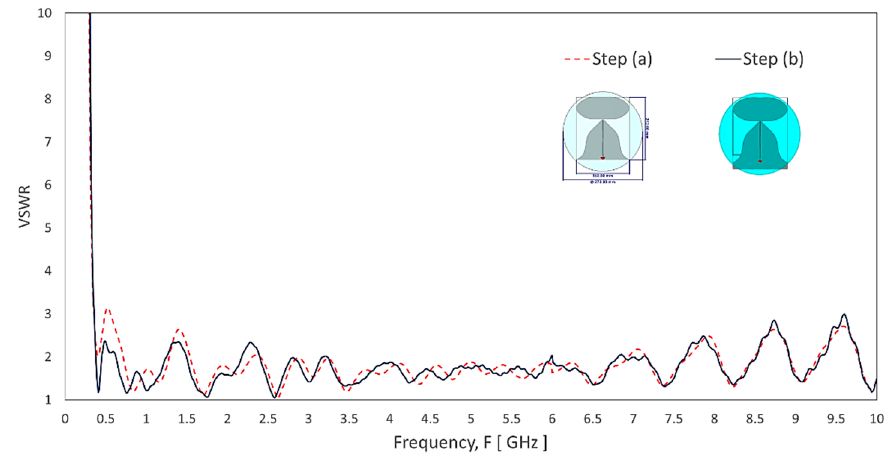
Figure 6. The simulated VSWR of the evolution steps from Figure 4: Step (a) and Step (b). Sensors 2020 , 20 , x FOR PEER REVIEW 10 of 33